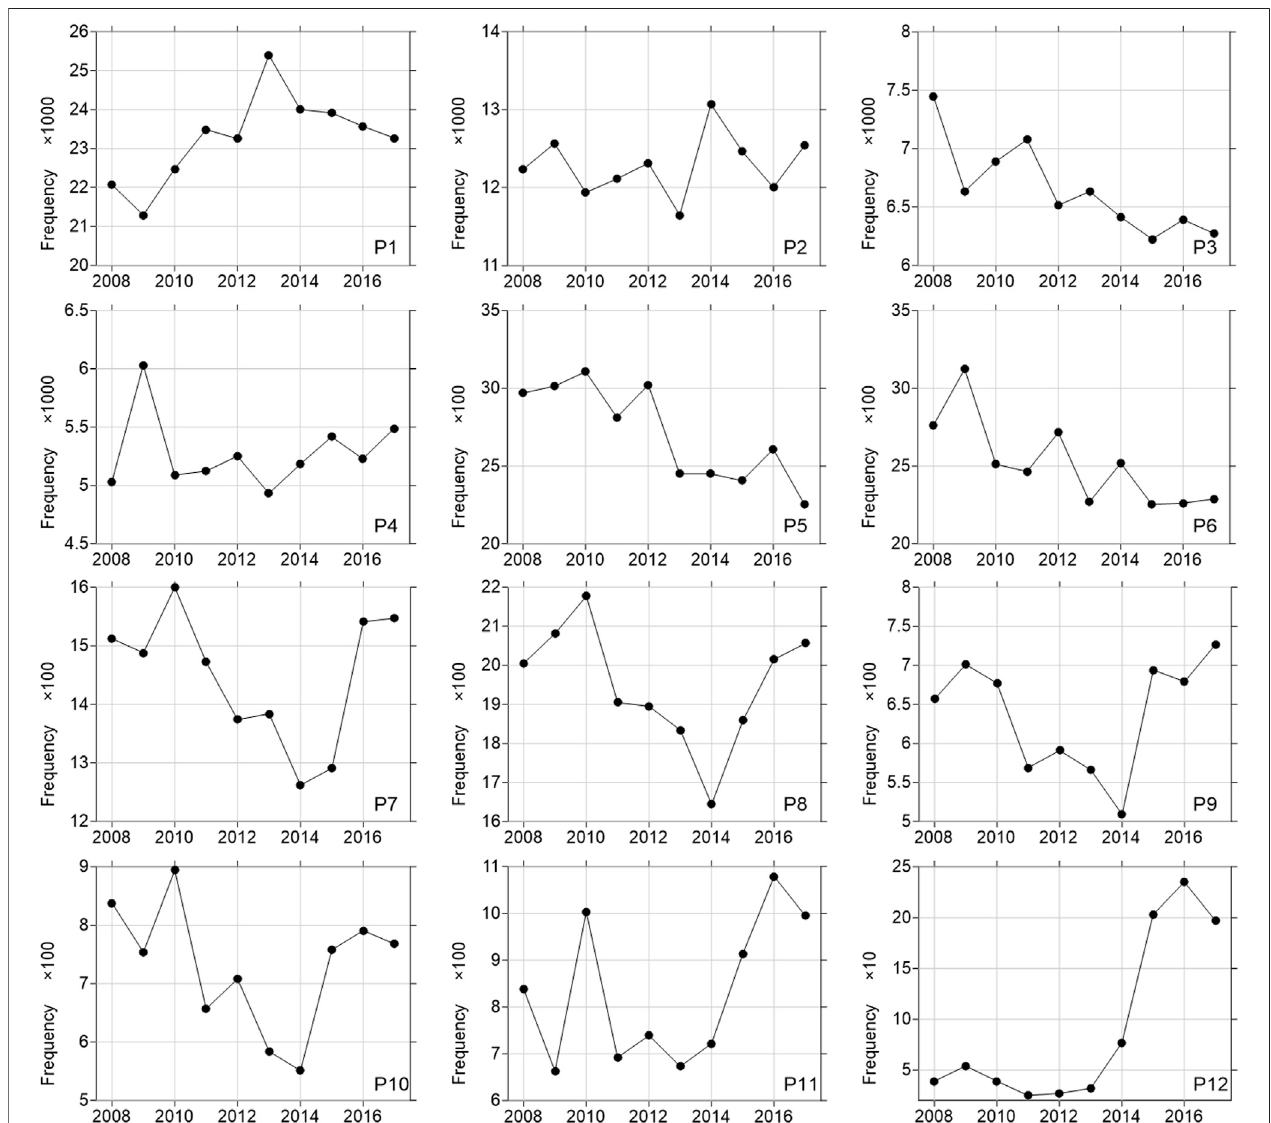
FIGURE11| Interannualvariationofdifferentwindspeedclusters(P1 – P12).The X -axisrepresentstime,andthe Y -axisrepresentsthetotalfrequency(unit:days)of one wind speed cluster at all stations. The coef fi cient in the fi gure represents the multiple of the actual data.